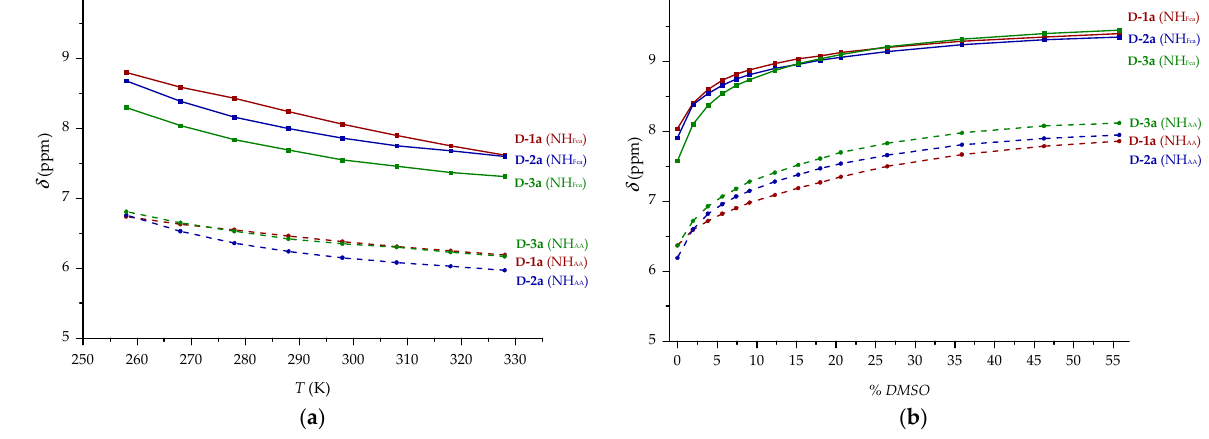
Figure 4. ( a ) Temperature dependence of the amide proton chemical shifts for D - 1a – 3a . ( b ) Solvent dependence of the amide proton chemical shifts of D - 1a – 3a while increasing concentrations of DMSO- d 6 in CDCl 3 - d